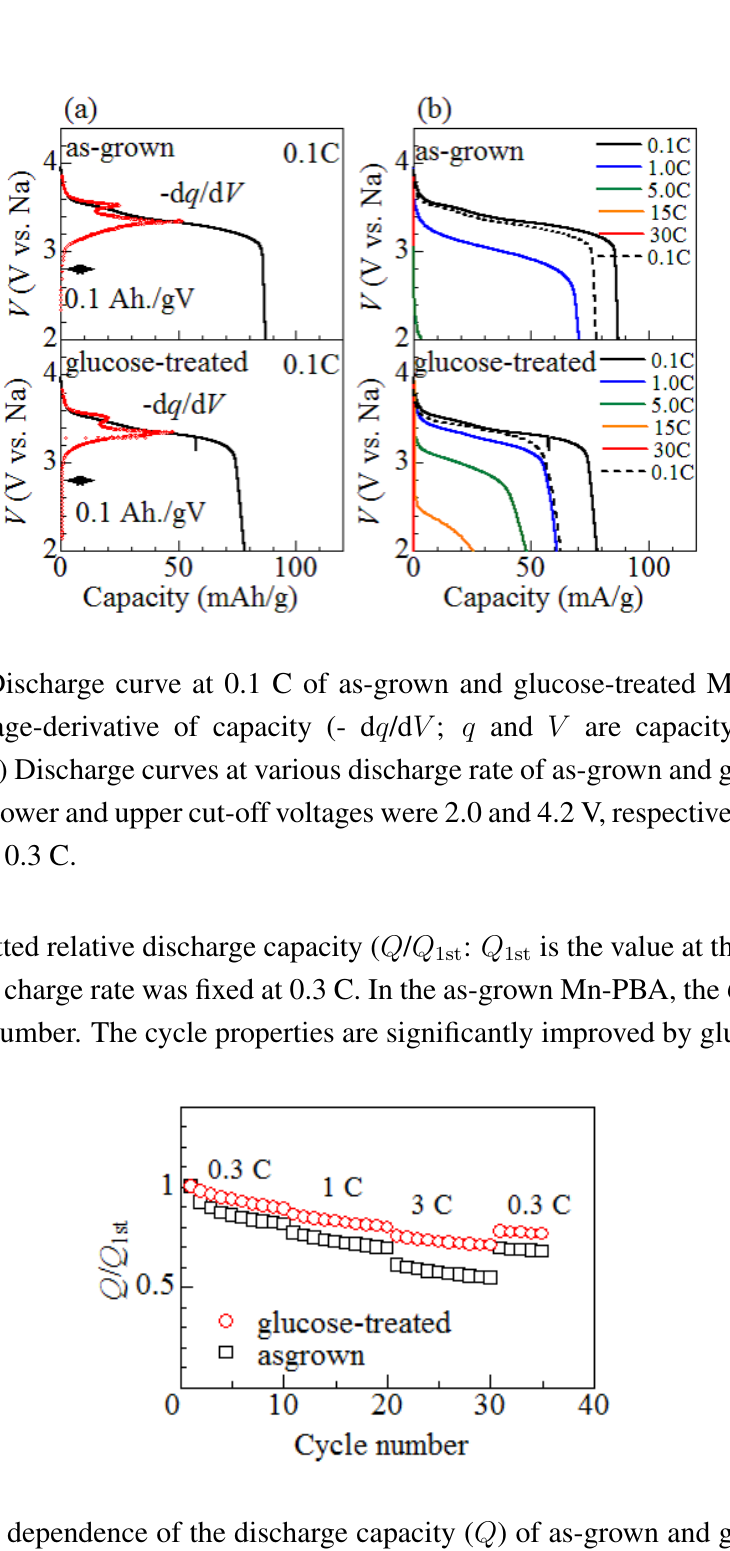
Figure 6. Cycle dependence of the discharge capacity ( Q ) of as-grown and glucose-treated Mn-PBAs. Q is the discharge capacity of the first cycle. The lower and upper cut-off 1st voltages were 2.0 and 4.2 V, respectively. The charge rate was fixed at 0.3